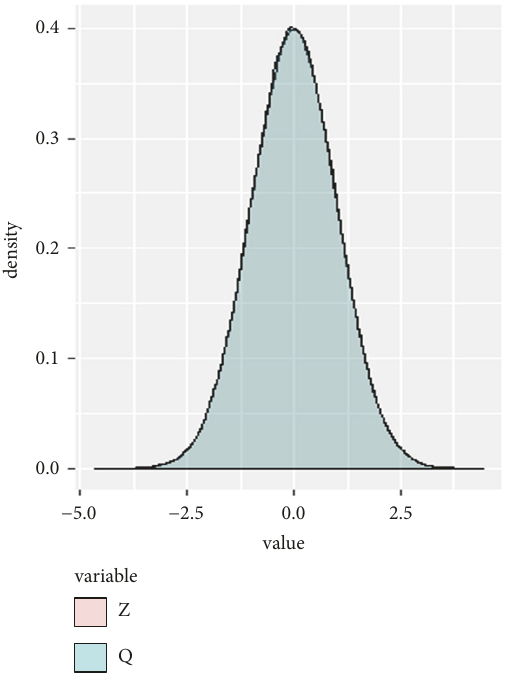
Figure 3: Kernel density plot of 𝑍 and 𝑄 at 𝑛 = 3 , 𝑇 = 𝑀𝑅𝑆𝑆 , and 𝜌 = 1 𝑋𝑌